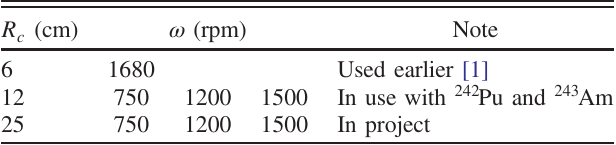
TABLE II. Parameters of the rotating targets.